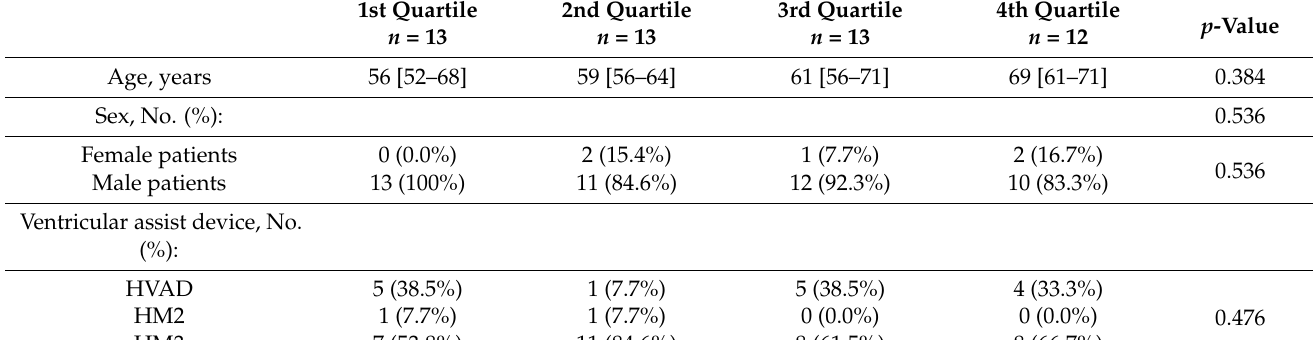
Table 2. Baseline characteristics according to the quartiles of